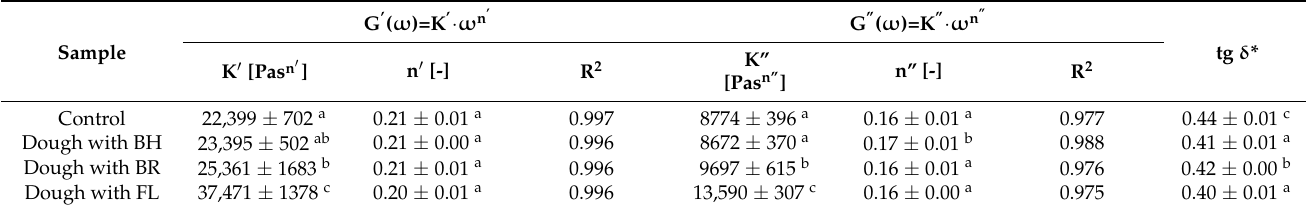
Table 4. Parameters of power-law model of rye–wheat dough samples.